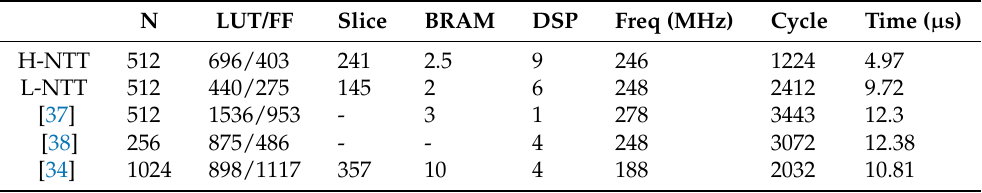
Table 2. FPGA implementation resource comparison of NTT